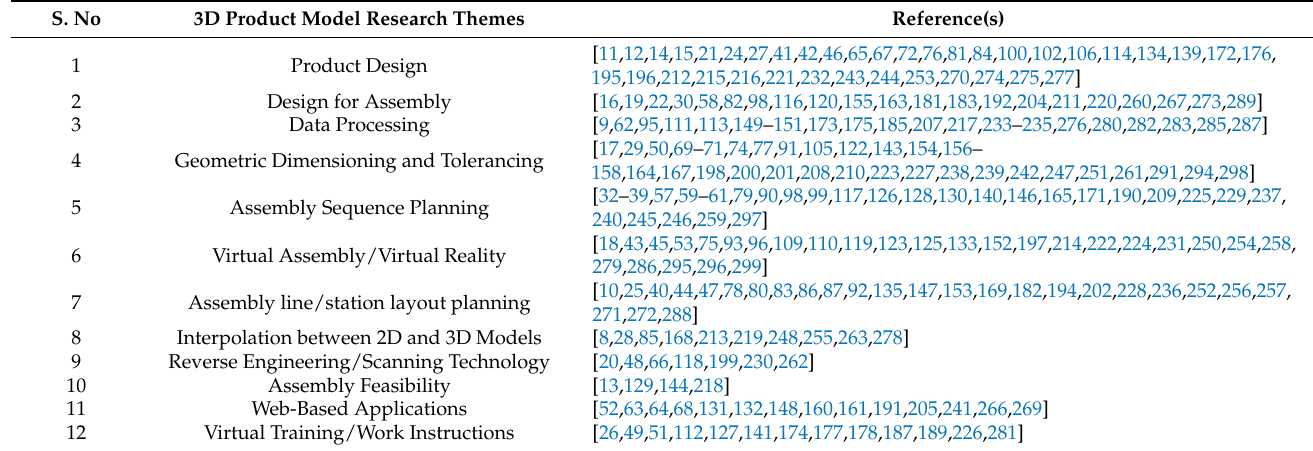
Table 3. Three-dimensional (3D) product model research themes and associated references